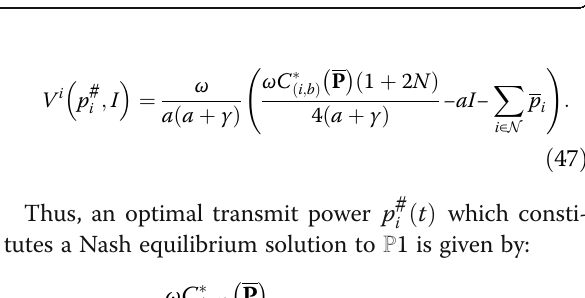
Fig. 12 Optimal data rate comparison among six per-link flows through our proposed ODRU algorithm for different discount factors under saturation value ^ L b ¼ 950